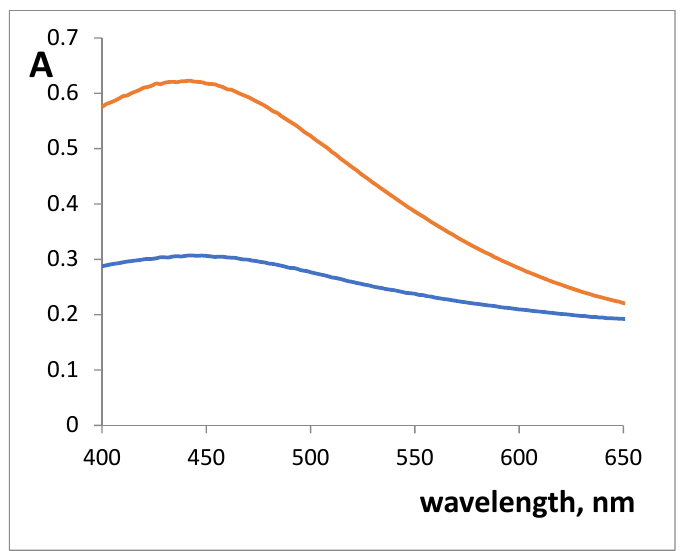
Figure 2. Absorption spectra of silica xerogels doped with iron(III) absorbance after the interaction with 3 ∙ 10 − 3 M salicylhydroxamic acid (SHA). m/V = 0.10 g/5.0 mL, pH 3.3, time of contact is 30 min. blue—SiFe1, red—SiFe10.